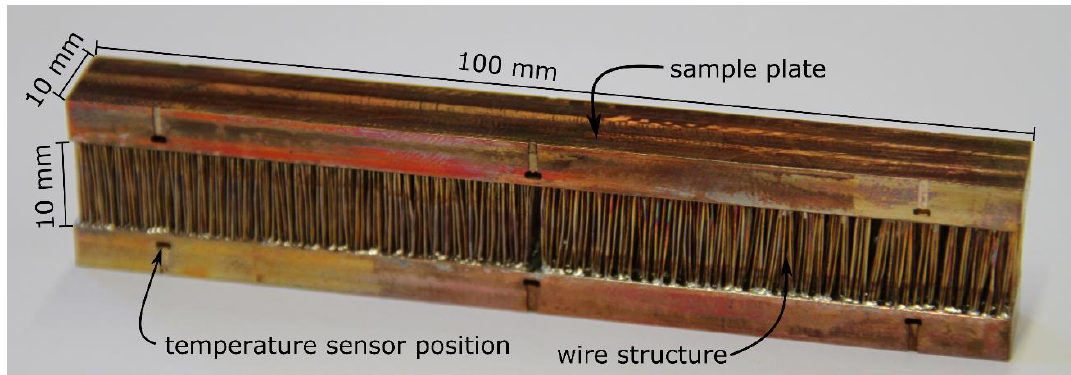
Figure 3. Section of an idealized wire structure heat exchanger with parallel wires between two separating plates; possible design with pin fins and flat tubes ( left ); Arrangement of wires ( right ).